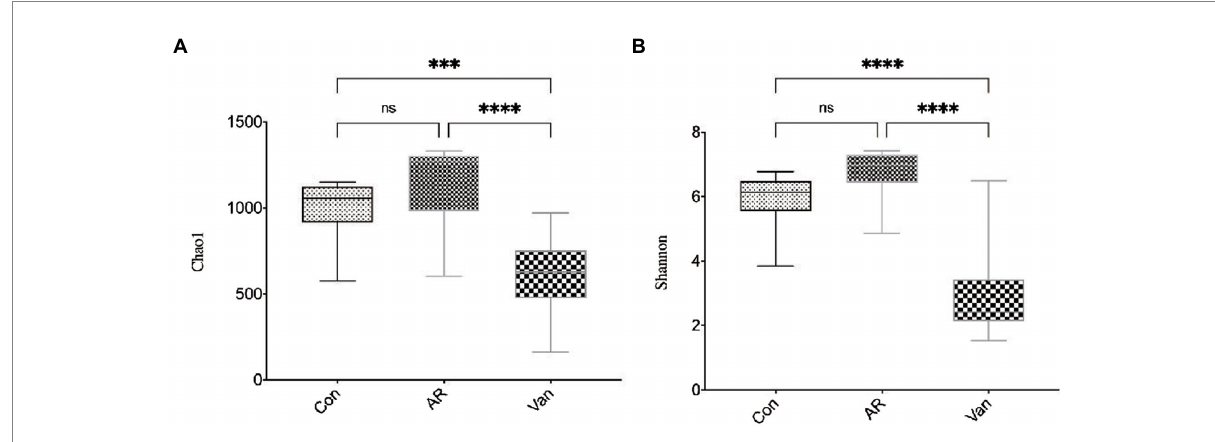
FIGURE 4 Vancomycin reduced the richness and diversity of gut microbiota in AR mice. Chao1 index (A) and Shannon index (B) at the overall level of OUT; ∗∗∗ p < 0.001, ∗∗∗∗ p <